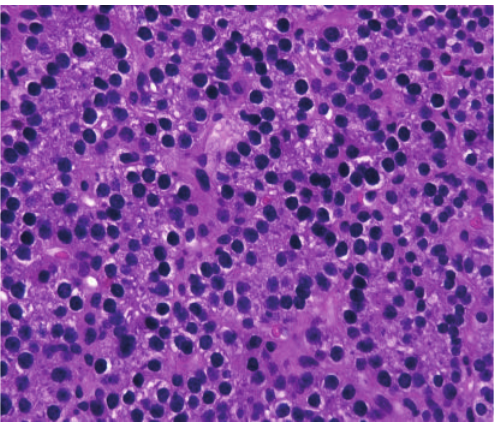
Figure 2: H&E staining; magnification × 40; demonstrates a parathyroid adenoma composed of chief cells with some oxyphil cells in a delicate capillary